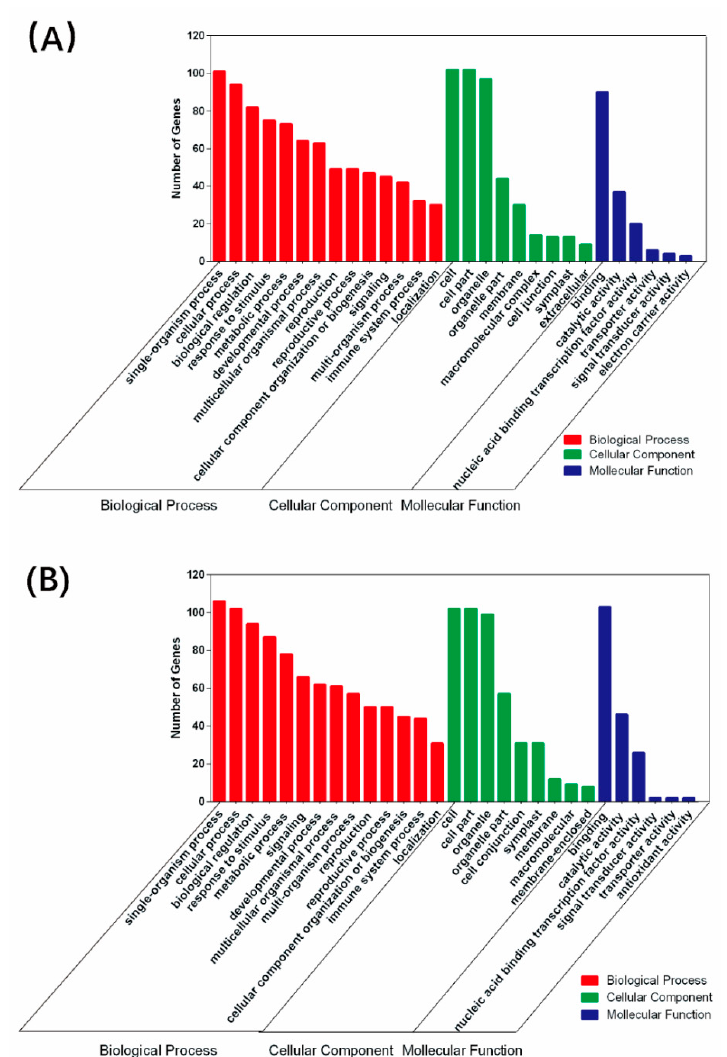
Figure 5. Gene ontology classification of potential target genes for differentially expressed miRNAs in salt ( A ) and alkali ( B ) stress. Red, green and blue represent three GO ontologies: biological progress, cellular component and molecular function, respectively.